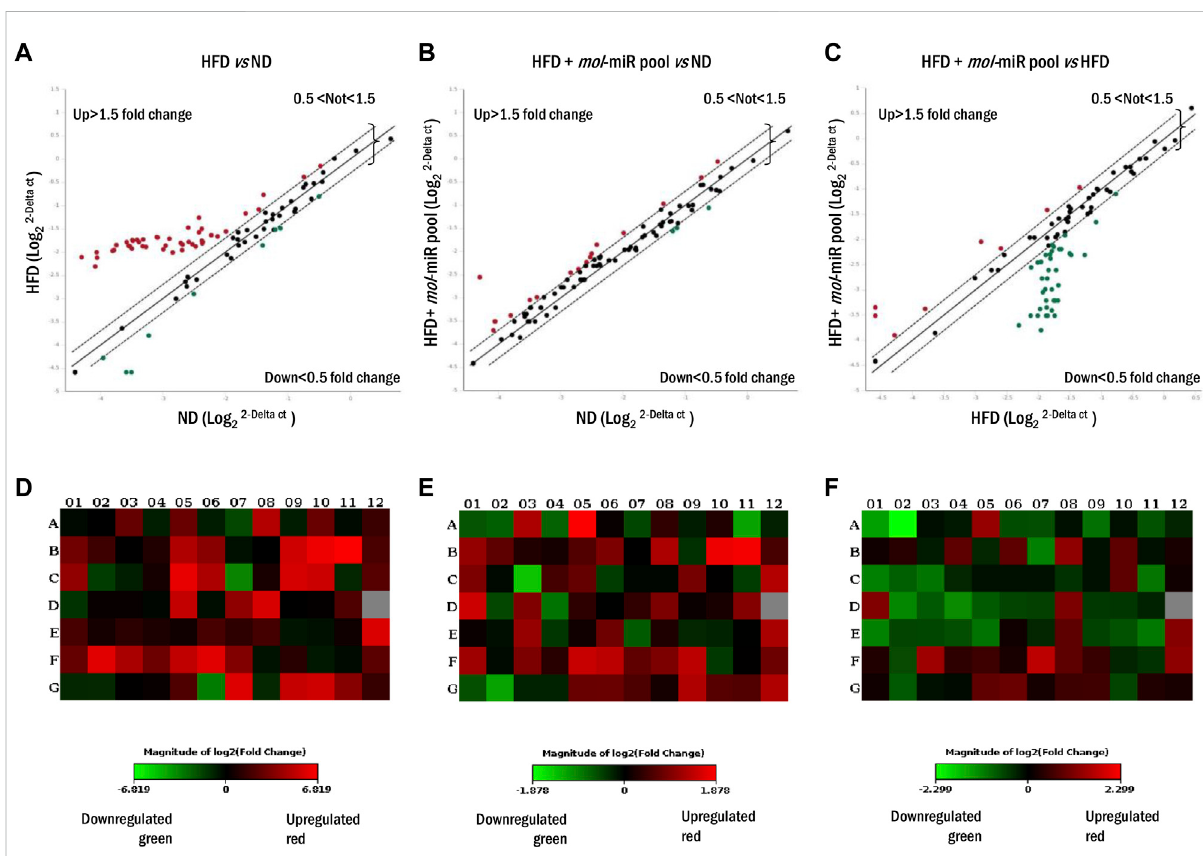
FIGURE 5 Lipid metabolism gene expression pro fi le in livers of mice fed for 5 weeks with HFD and HFD + mol -miR pool. (A – C) Liver scatter plot array pro fi le. Transcriptional levels of speci fi c genes are shown as fold change. Values > 1.50 or < 0.5 were considered signi fi cantly upregulated (red dots) and downregulated (green dots), respectively. Values between 1.5 and 0.5 were considered not regulated. (D – F) The relative Heat Map shows the expression of upregulated (red) and downregulated (green) genes in livers of mice subjected to (D) HFD vs . ND group, (E) HFD + mol -miR pool vs . ND group, (F) and HDF + mol -miR pool vs . HFD